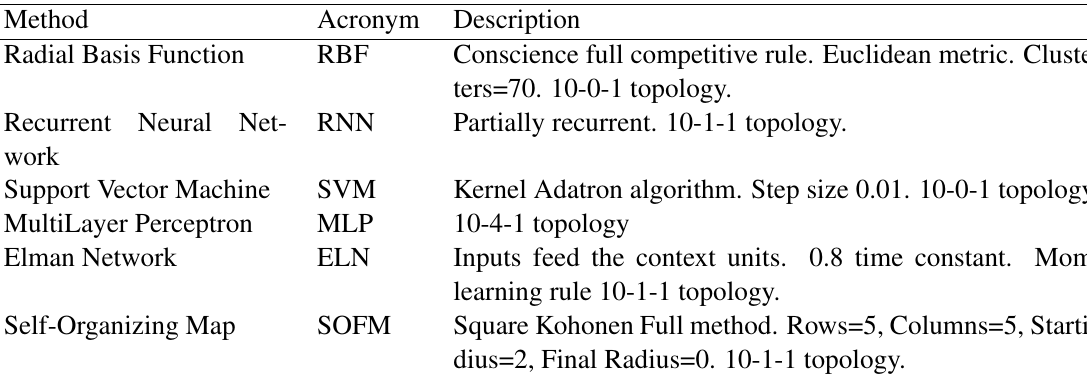
Table 5: Overview of ANN and cost function strategies included in the stage 1.